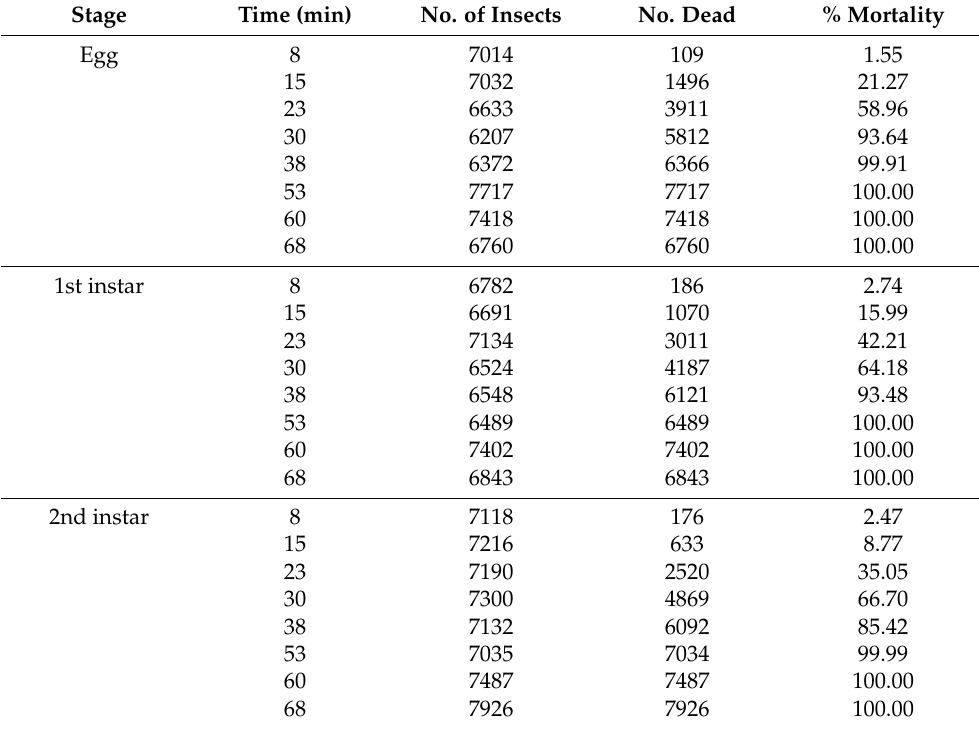
Table 2. Time–mortality relationship for the immature stages of B. dorsalis in Tommy Atkins mango fruit after immersion in hot water of 46.1 ◦